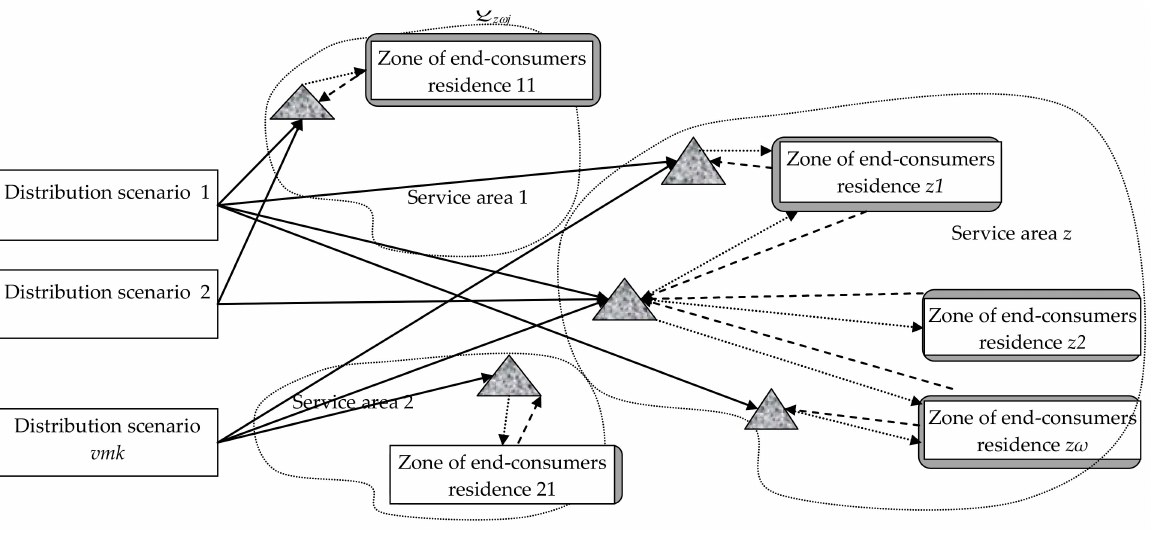
Figure 3. Distribution of goods in consumer-driven logistics: —retailer; —material